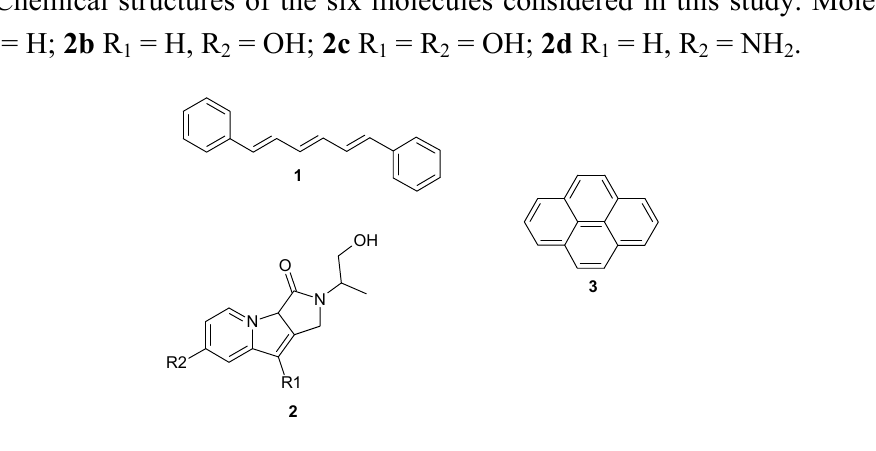
Figure 2. Chemical structures of the headgroup and linking region of DPPC (left) and sphingomyelin (right). In all cases, the R groups are fatty acid